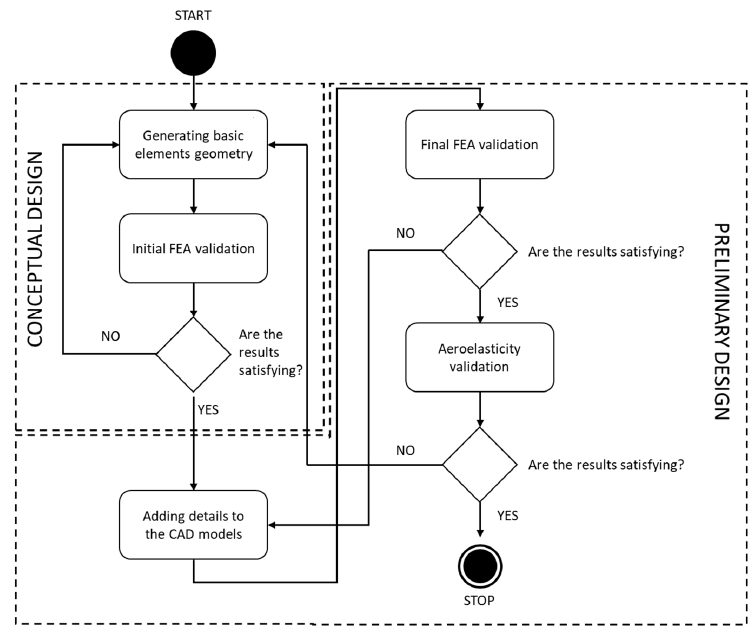
Figure 5. The general schema of the developed methodology.